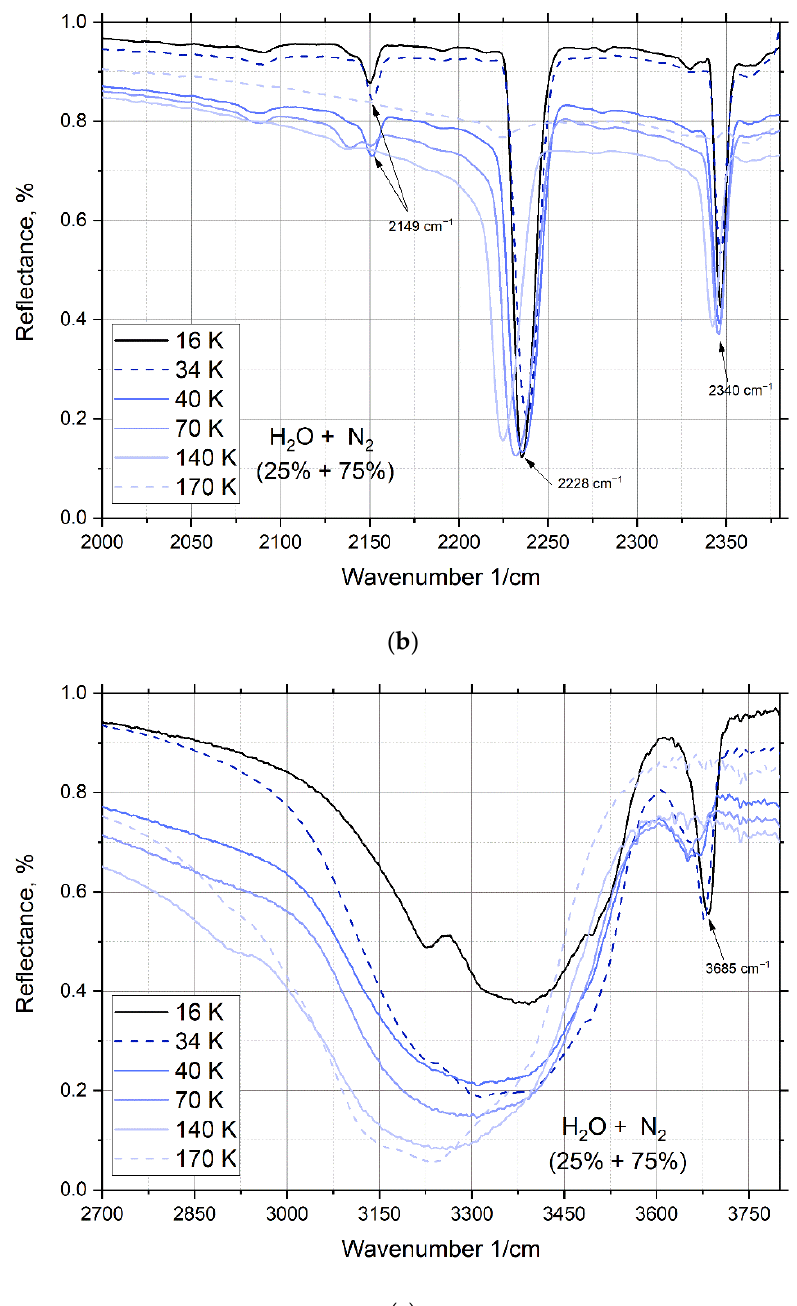
Figure 6. IR spectra of a mixture of water and nitrogen deposited by PVD: ( а ) from 1000 to 1400 cm −1 ; ( b ) from 2000 to 2400 cm −1 ; ( с ) from 2700 to 3750 cm −1 .